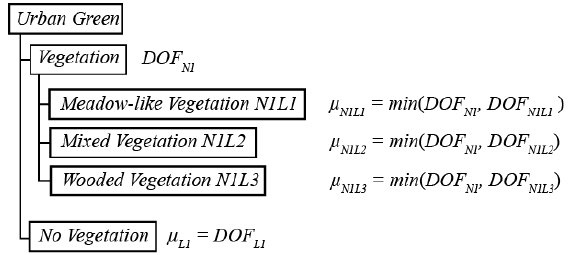
Figure 2. Class hierarchy of an Urban Green classification in a WorldView-2 scene of Munich.